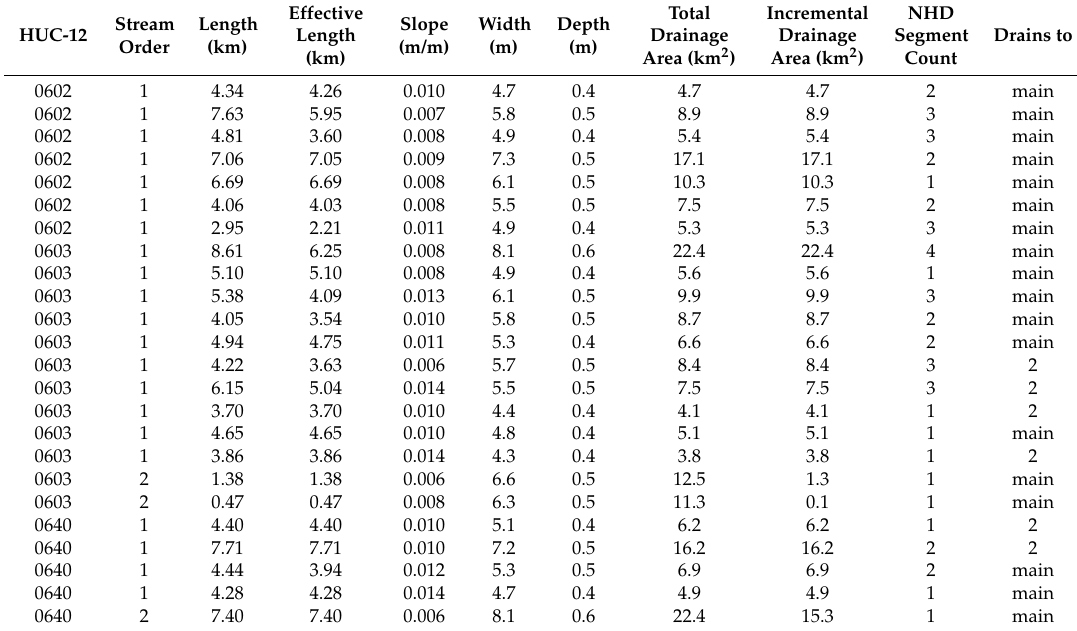
Table 1. Channel characteristics for enhanced SWAT+ configuration as depicted in Figure 4.